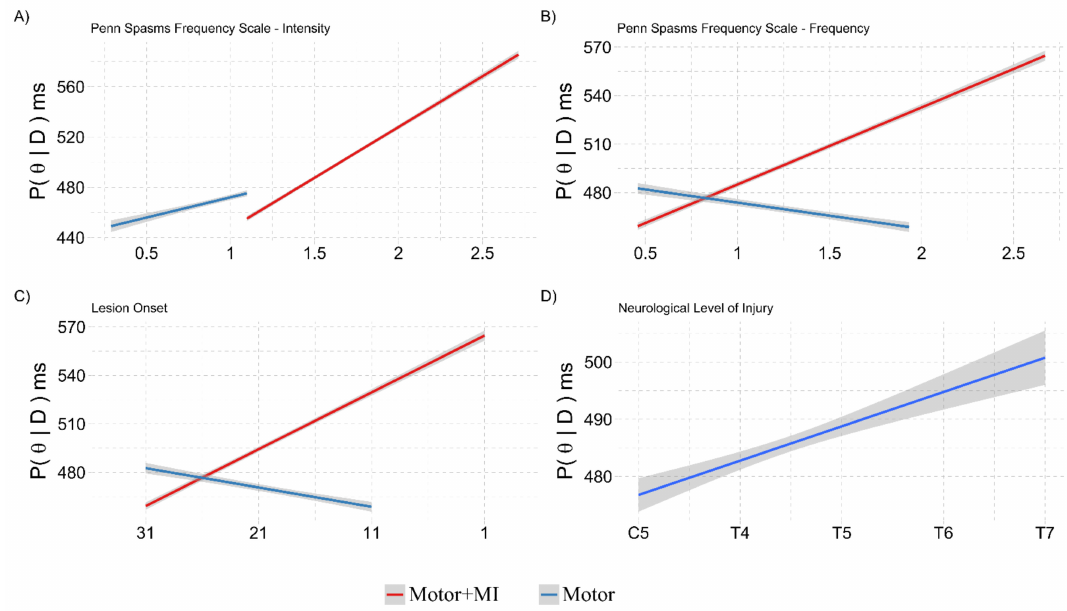
Figure 10. Graphical representation of the marginal posterior distributions (P( θ |D)) relating to the main effects and interactions in the Covariation of the BSE paradigm with Foot background at T1, with NLI, Lesion Onset PSFS and VMIQ-2 model. Slower values on the y -axis means a better body representation. The description is as in Figure 7. In panels ( A , B ) the x -axis shows the scores of the respective scales. In panel C the x -axis shows the number of years since the Lesion Onset and the beginning of the training, while in panel D the Neurological Level of injury. Motor + MI = Motor Treatment and Motor Imagery group. Motor = Motor Treatment only